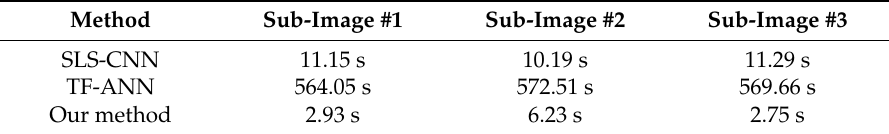
Table 7. The cost time of various methods on the experiment data.